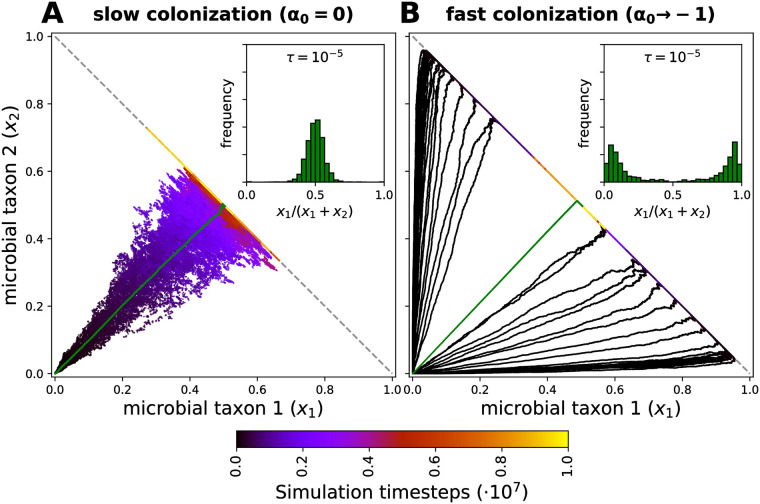
Individual-based simulations of colonization for two neutral microbial taxa.The colonization trajectory of 50 microbe-free hosts is shown, with colors indicating the time of sampling. Each trajectory is composed of 104 points, with the green line indicating the mean and the dashed line indicating full colonization. Insets show the distribution of x1/(x1 + x2) for time steps sampled according to a host death-birth probability τ = 10−5 in Eq (6). (A) When hosts are colonized slowly, the trajectories maintain a mean frequency given by the pool of colonizers (pi), but show an increased standard deviation before full colonization, which decreases later to reach xi ≈ pi at the long-term equilibrium. (B) When hosts are colonized rapidly, the mean frequency across many hosts is conserved, but the distribution becomes bimodal as a result of the fast proliferation of the first colonizer, and a slower convergence to the long-term equilibrium. The inset shows the distribution of taxon 1 over the simulated time. For finite host lifespans and fast colonization, such dynamics can produce alternative microbiome states at the population level (inset in B). Sampling was performed every 10 time steps in a simulation of 107 time steps. Other parameters: N = 104, m = 0.01, p1 = p2 = 0.5, and α1 = α2 = 0.